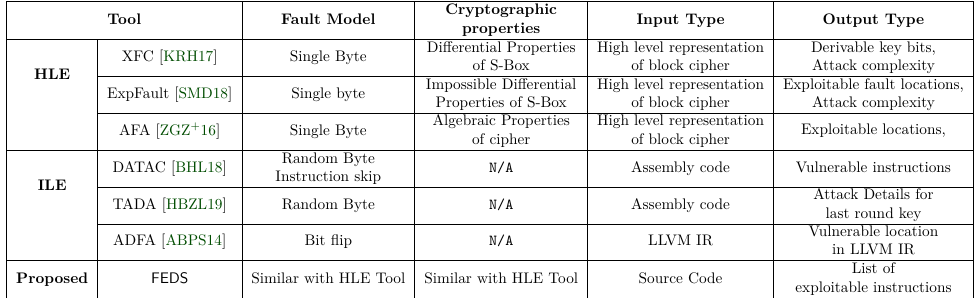
Table 1: Comparison with the state-of-the-art automatic fault attack evaluation